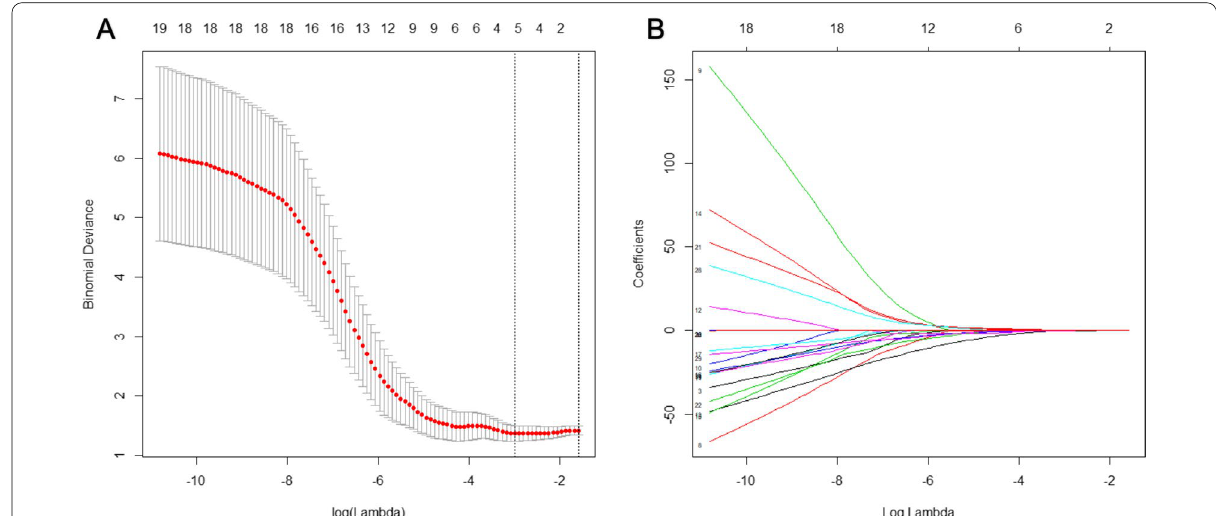
Fig. 1 Key texture features selection of DCE MRI quantitative parameters by LASSO analysis. a The value of regularization parameter ( λ ) selected by tenfold cross-validation when the deviance was minimal. b A coefficient profile plot of 33 texture features was produced against the log ( λ ) sequence. Total 4 nonzero coefficients were selected finally by the optimal λ. LASSO, least absolute shrinkage and selection operation